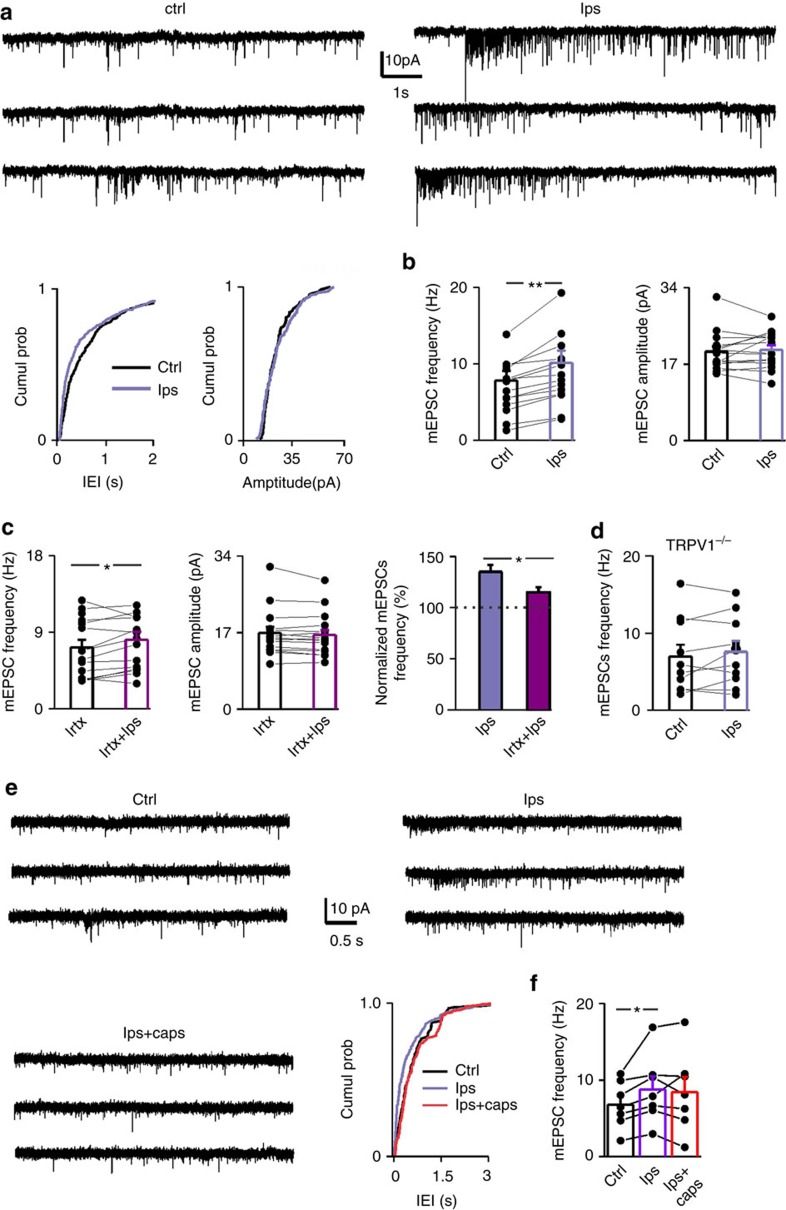
TRPV1 tonically controls LPS-mediated effects.(a) Example recording of mEPSCs in control (ctrl) and during LPS exposure (500 ng ml−1). Below the cumulative probability plot of mEPSC interevent interval and amplitude (P<0.01 and P=0.24, respectively, KS test). (b) Population plot of mEPSC frequency before (black bar and filled circle) and during LPS (violet bar and filled circle), showing that LPS, similarly to capsaicin, increases selectively the mEPSC frequency (from 7.67±1.32 to 10.09±1.73 Hz, n=14, P<0.001 Paired Sample Wilcoxon Signed Rank test) without a significant effect on the amplitude (from 20.05±1.30 to 19.76±1.32 pA, P=0.5 Paired Sample t-Test). (c) As in b, but in the presence of 300 nM IRTX (from 6.8±1.06 to 7.78±1.19 Hz, n=14, P<0.01 Paired Sample Wilcoxon Signed Rank test; from 17.47±1.17 to 17.11±1.23 pA, P=0.09 Paired Sample Wilcoxon Signed Rank test). Right, the percentage increase of mEPSC frequency by LPS in the presence of the TRPV1 antagonist IRTX, is significantly reduced compared with the rate enhancement induced by LPS applied alone (P=0.01 Mann–Whitney test). (d) Population data of mEPSC frequency in control and during LPS obtained from PNs of TRPV1−/− mice (from 7.36±1.90 to 7.69±1.81 Hz, n=9, P=0.52 Two Samples t-Test). (e) Trace records from a PN in control condition (ctrl), in LPS and LPS plus capsaicin. Following LPS perfusion, capsaicin is no longer able to further facilitate glutamatergic neurotransmission. Right below, cumulative distribution probability of the interevent intervals from the same neuron (ctrl versus LPS P>0.0001, LPS versus caps P<0.0001, ctrl versus caps P=0.54). (f) Summary graph of mEPSC frequency before (black bar), during LPS (violet bar) and LPS+caps (red bar) (ctrl 6.69±1.15 LPS 8.78±1.68 Hz, LPS+caps 8.45±1.97 Hz, n=7,ctrl versus LPSP<0.05, LPS versus LPS+caps P=0.68, ctrl versus LPS+caps P=0.15 Paired Sample t-Test;. Data are values from single cells and/or mean±s.e.m. *P<0.05, **P<0.001.